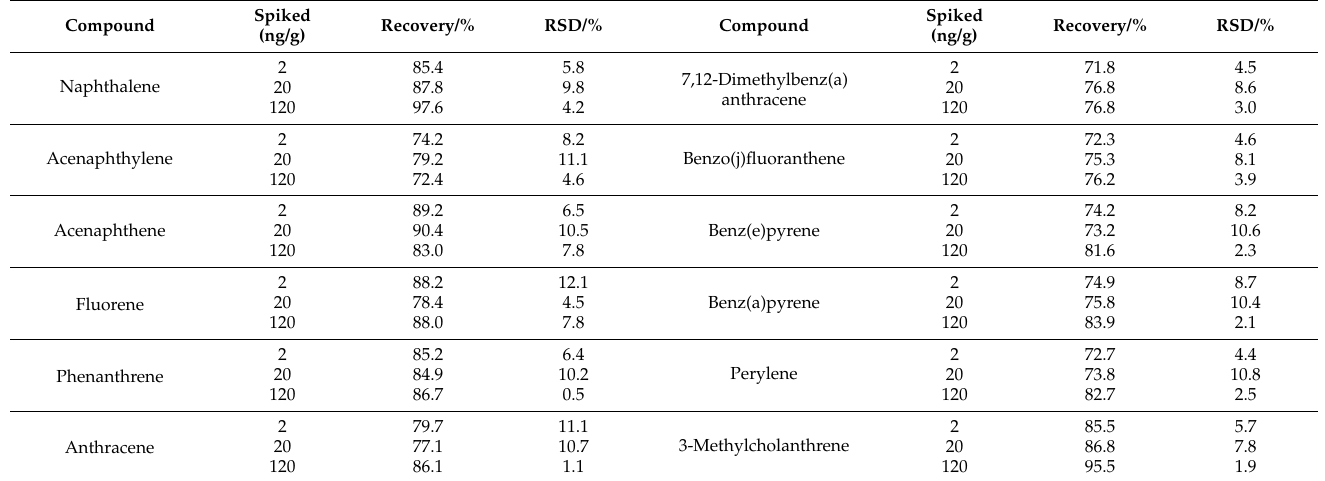
Table 3. Spiked recoveries and precision of PAHs in leaves ( n =